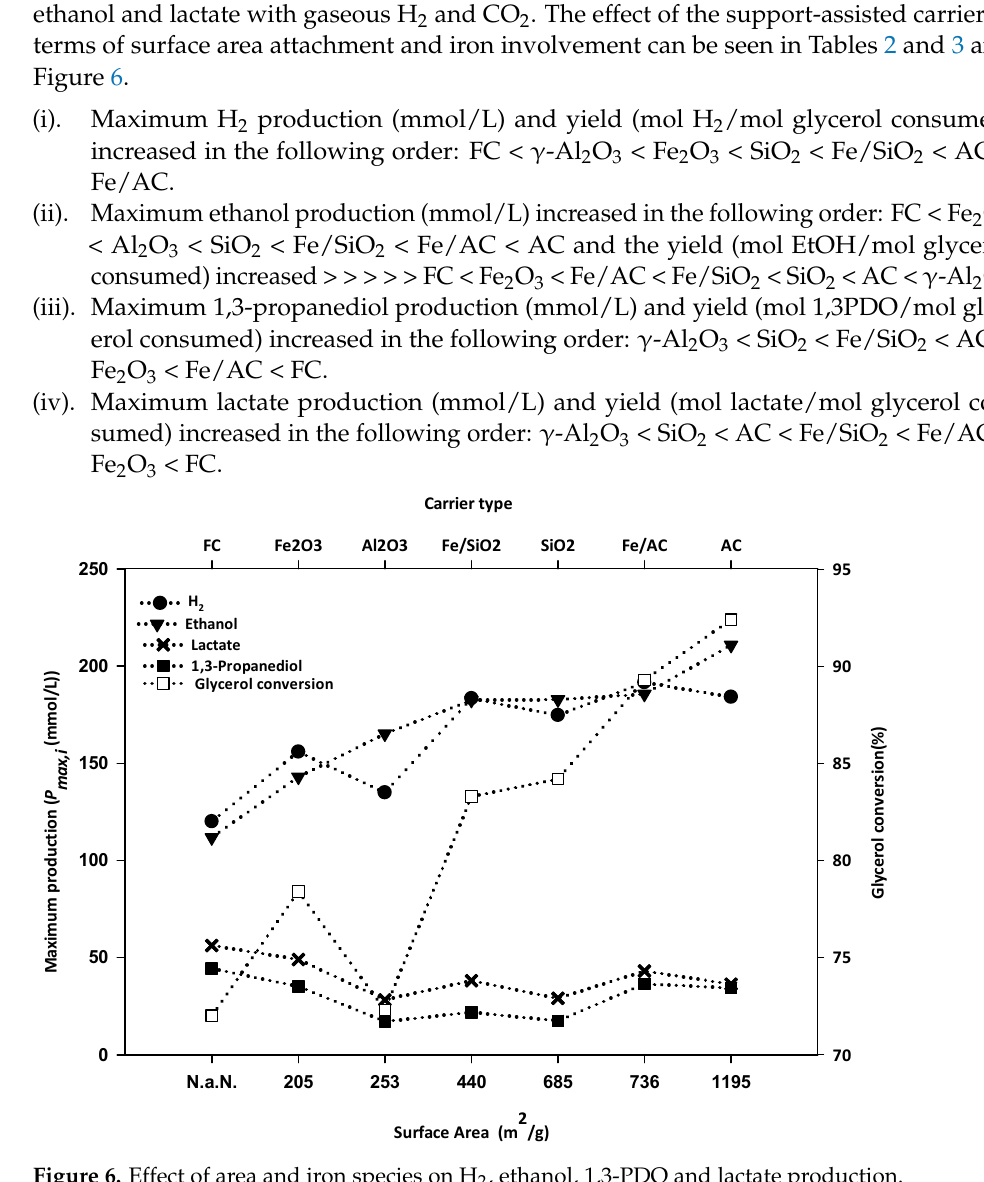
Figure 6. Effect of area and iron species on H 2 , ethanol, 1,3-PDO and lactate production.